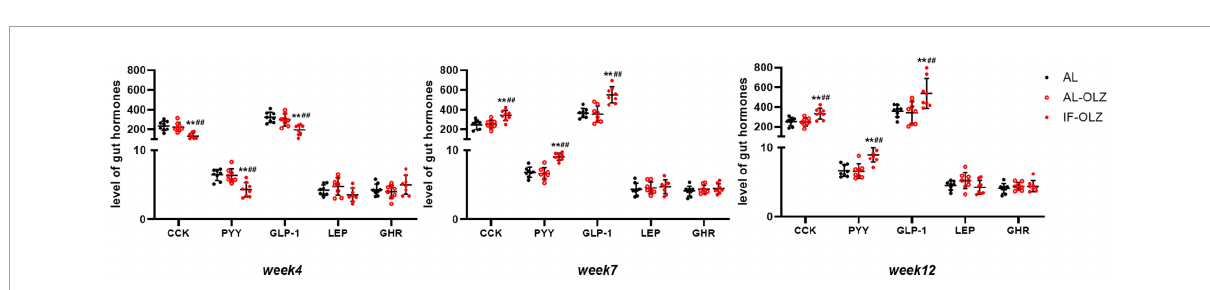
FIGURE5 Group data showing the changes in circulating gut hormones. Gut hormones in AL, AL-OLZ, and IF-OLZ mice, n = 8. One-way ANOVA plus Tukey’s test was performed for the data analysis. Mean ± SD; ** P < 0.01 vs. AL; ## P < 0.01 vs. AL-OLZ. CCK, cholecystokinin (pg/ml); PYY, peptide YY (ng/ml), GLP-1, aglucagon-like peptide 1 (pg/ml), LEP, leptin (ng/ml), GHR, ghrelin